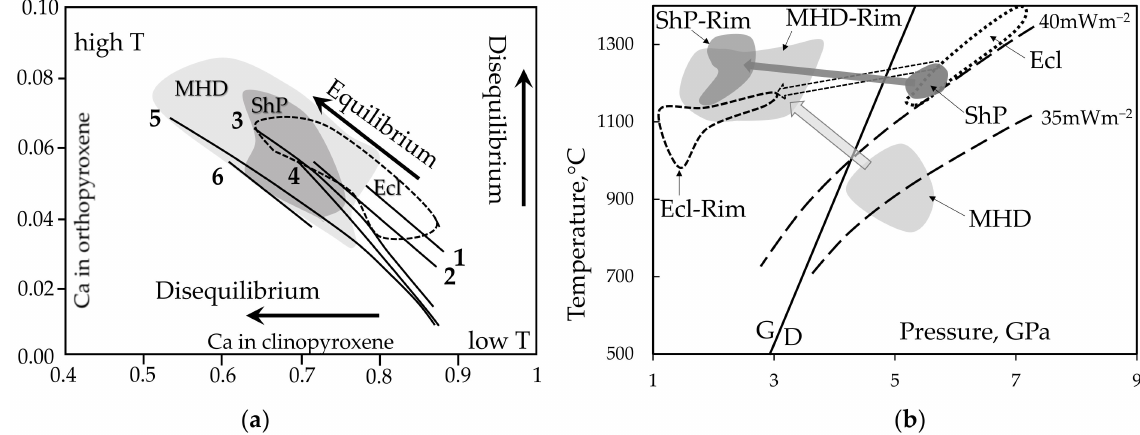
Figure 6. PT parameters of MHD, ShP, and Ecl kelyphite rims 1–2: ( a ) Fields of equilibrium pyroxene pairs in the rims surrounding studied xenoliths garnets in the diagram Ca in orthopyroxene versus Ca in coexisting clinopyroxene based on six oxygens per formula unit [50]. Lines 1–6 show the equilibria in the experimental system at temperatures of 900–1400 ◦ C and pressures of 1–6 GPa [51]; ( b ) PT for the kelyphites calculated using geothermometers BK90 [52] and geobarometers MG74 [53], FB87 [54]; P-T parameters of the studied peridotites were calculated according to [55,56], data for eclogites were taken from [31]; the solid line GD separates the stability fields of graphite and diamond [57]; dotted lines—mantle geotherms 40 and 35 mwm − 2